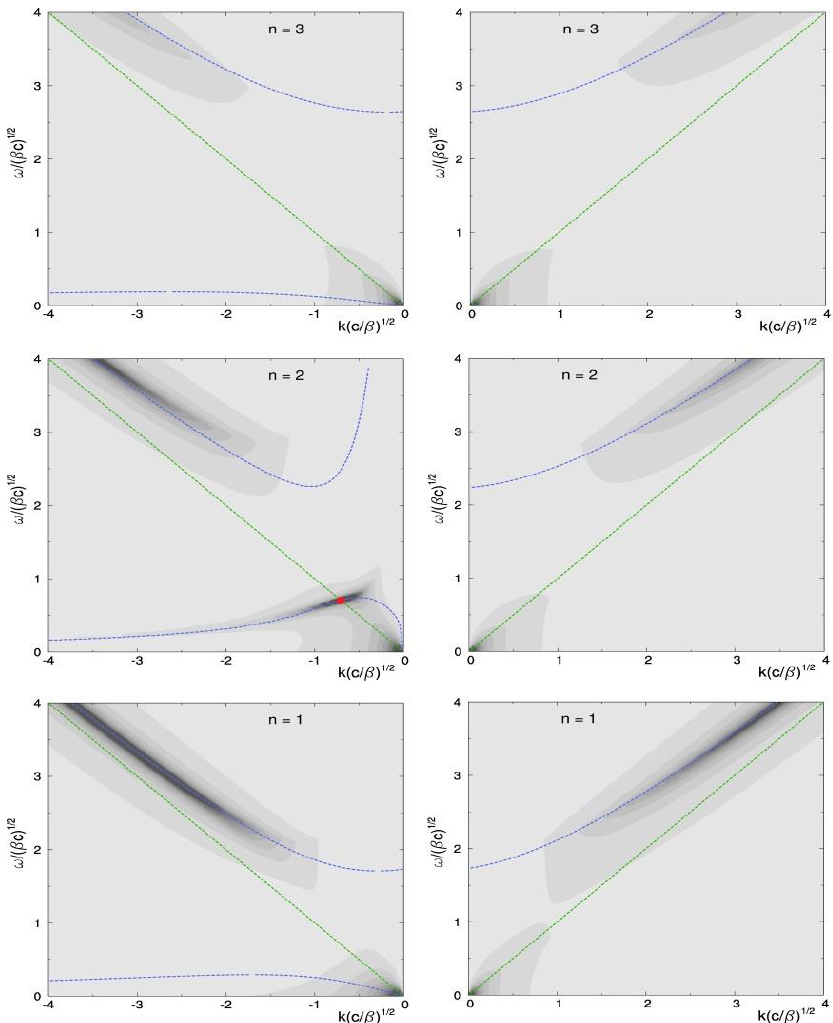
Figure A3. Response factor of ( left ) the westward and ( right ) the eastward travelling modes with n = ( bottom ) 1, ( middle ) 2 and ( top ) 3, where c is the phase speed of the gravity wave. The shading density is directly proportional to the response factor with a contour interval of 4. The green and blue lines represent the zonal and meridional resonance conditions, respectively. The blue lines also represent the dispersion relationship of the free modes except for the westward travelling mode with n = 2. The red spot indicates that both resonance conditions are satisfied.